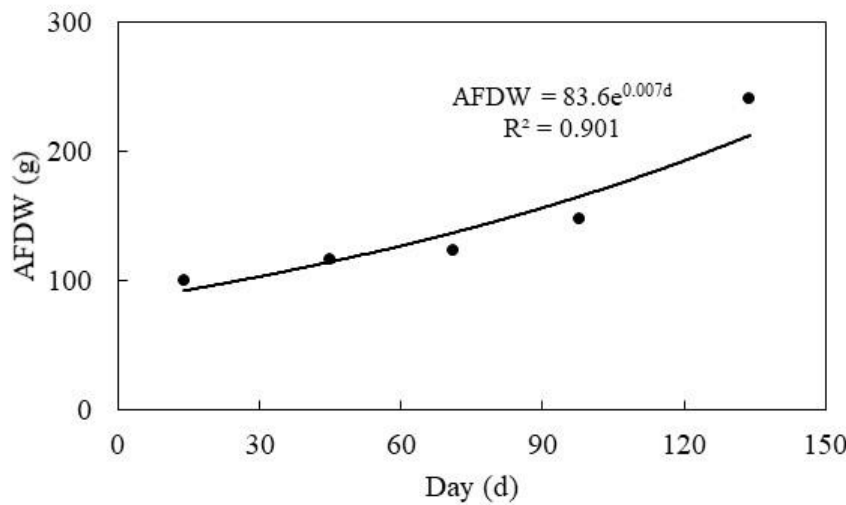
Figure 2. Halichondria panicea. Exponential regression curve (LM, t 0.045, 3 = 5.8 × 10 −4 , p = 0.014) showing an approximately average growth rate of 0.7% d −1 . Based on data from [35] shown in Table A2.